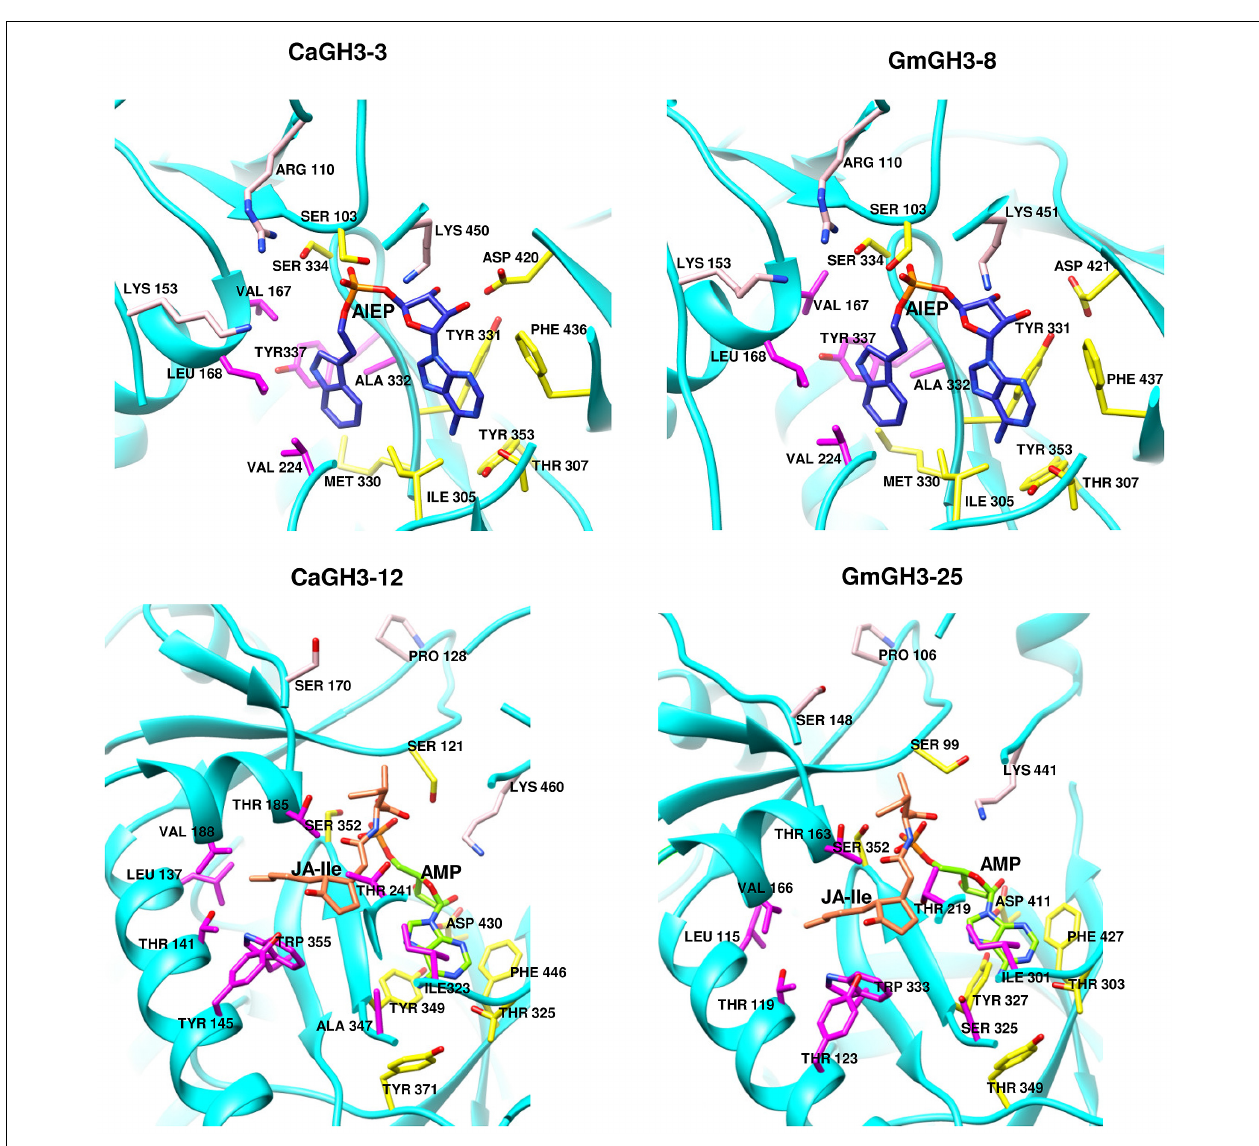
FIGURE 7 | Hormone and nucleotide binding residues in GH3 proteins. Ribbon diagram showing hormone binding residues in magenta, nucleotide (ATP/AMP) binding residues in yellow, and residues in pink determine amino-acid preferences.